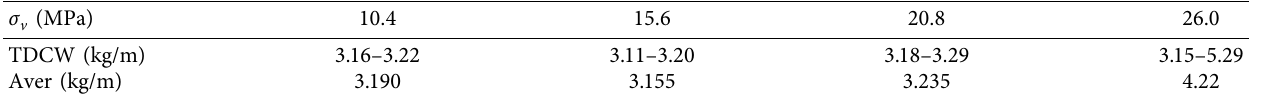
TDCW, total drilling cutting